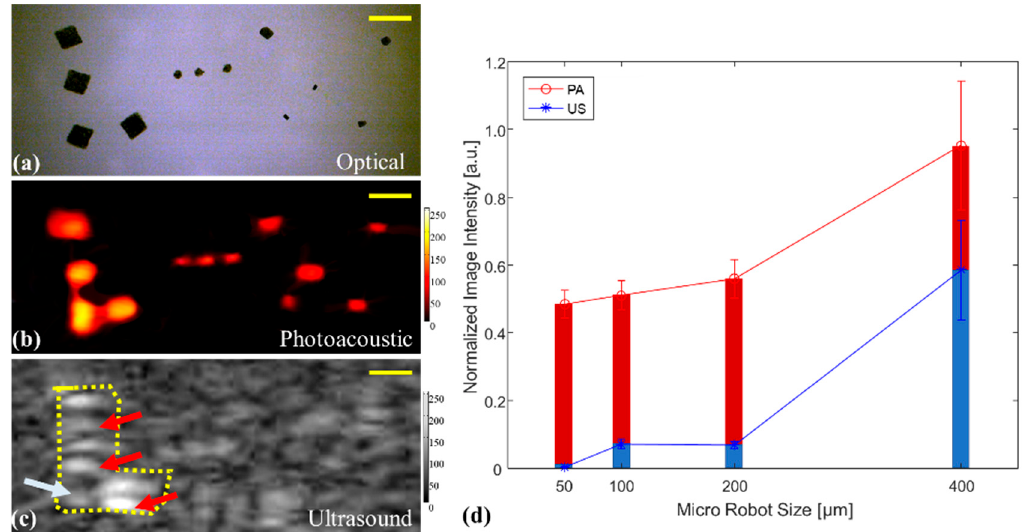
Figure 2. Imaging result of static microrobots with different sizes in a pattern of “L•••W.” ( a ) Reference photo through the optical camera in an open workspace. ( b ) The detected PA image in an enclosed workspace. ( c ) Imaging result of the US method. The red arrows indicate the US artifacts, and the white arrow shows the microrobot was not detected in the US. ( d ) Imaging intensity analysis for US and PA methods of detecting varied dimensions of microrobots. The scale bars are 1 mm.